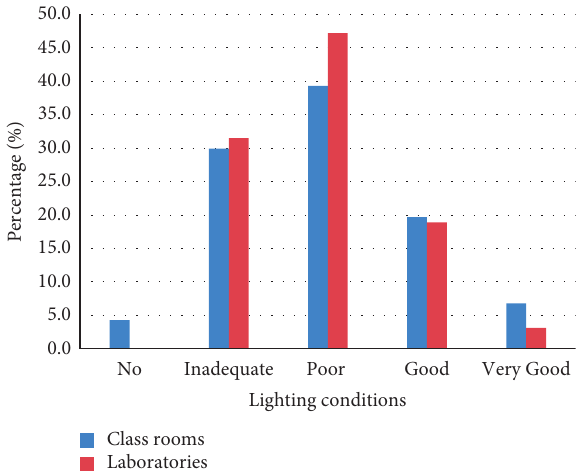
Figure 3: Status of lighting conditions in the classrooms and